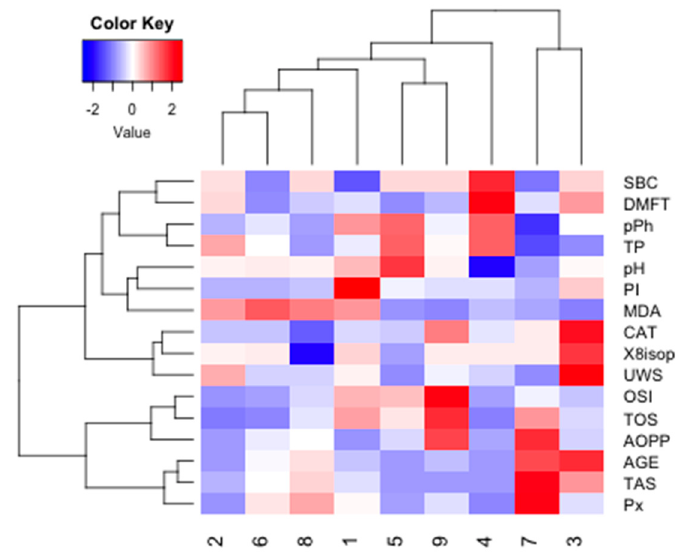
Figure 17. Cluster analysis for group NC. NC, patients with breast cancer but without the BRCA1 mutation. AOPP, advanced oxidation protein products; TP, total protein; OSI, oxidative stress index; TOS, total oxidant status; TAS, total antioxidant status; CAT, catalase activity; pPh, total phenolic content; Pl.I score, Plaque Index; DMFT, decay, missing, filled teeth; UWS, unstimulated whole saliva; SBC, salivary buffer capacity; 8-isop, concentration of 8-isoprostane; MDA, concentration of malondialdehyde; AGE, advanced glycation end-products; SBC, buffer capacity of saliva; Px, activity of salivary peroxidase.